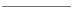
2 MON14, 27 mg of MON/kg of DM and adaption for 14 d; MON+VM14, 27 mg of MON/kg of DM and 25 mg of VM/kg of DM and adaption for 14 d; VM14, 25 mg of VM/kg of DM and adaption for 14 d; VM9, 25 mg of VM/kg of DM and adaption for 9 d; VM6, 25 mg of VM/kg of DM and adaption for 6 d. a − h Means without a common superscript letter differ (P < 0.01); pooled SEM (0.28, 4.88, 0.97, and